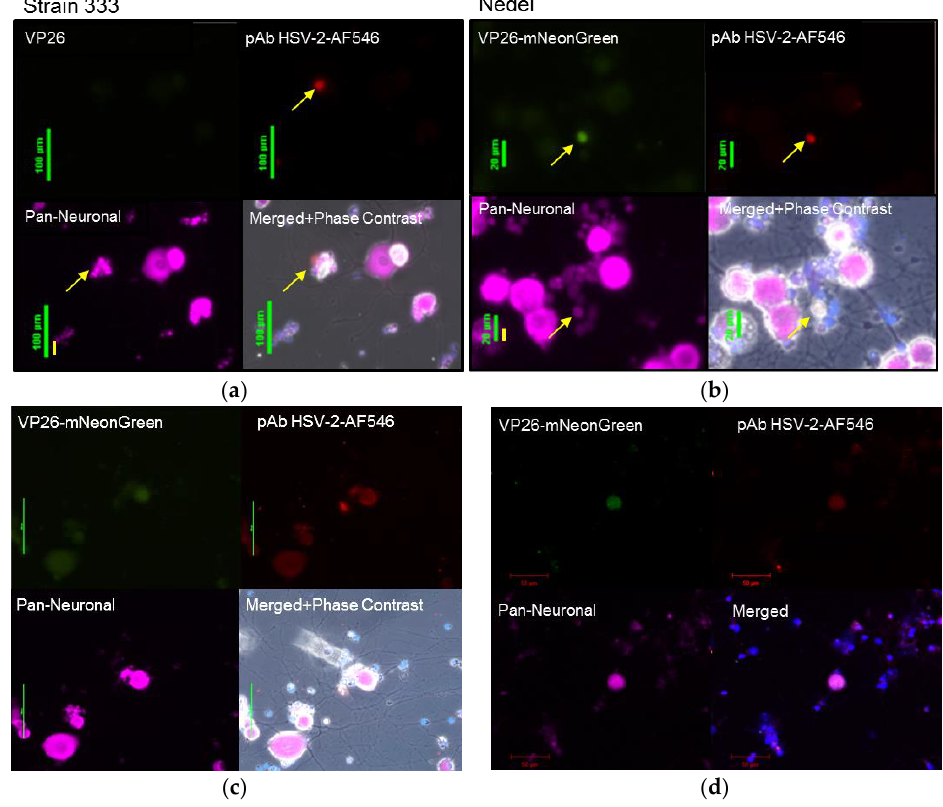
Figure 6. Ex vivo reactivation from explanted sacral dorsal root ganglia. Fluorescent images of enzymatically dissociated sensory neurons from guinea pigs 36 days post-infection and 72 h post-plating with either ( a ) Strain 333, green bar = 100 µm ( b ) Nedel, green bar = 20 µm, yellow bar = 10 µm. Upper left : Detection of mNeonGreen fluorescence (Strain 333 shows no fluorescence), Upper right : immunofluorescence using pAb HSV-2-AF546, Lower left : Pan-Neuronal stain, Lower right quadrant: Merged. Yellow arrow indicates reactivating neuron. ( c ) Explant with phase contrast, pAb HSV-2-AF546, DAPI, and a Pan-Neuronal stain, green bar = 50 µm ( d ) Confocal image of explant with staining strategy used in ( a – c ) without phase contrast, red bar = 50 µm.